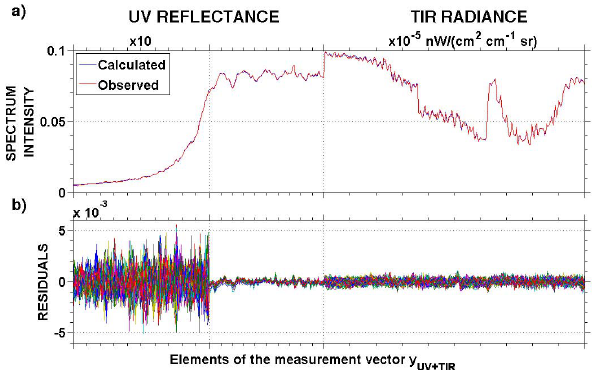
Fig. 1. Typical examples of co-localized radiance and reflectance spectra observed respectively by IASI and GOME-2 instruments and fitted by the IASI+GOME-2 approach. (a) Observed (red) and calculated (blue) elements in the IASI+GOME-2 measurement vector y UV+TIR including UV reflectances in the Hartley (left, mul- tiplied by 10) and Huggins (middle) bands and TIR radiances (right, divided by 10 5 ). (b) Fitting residuals of 200 typical spectra in the same units as (a)